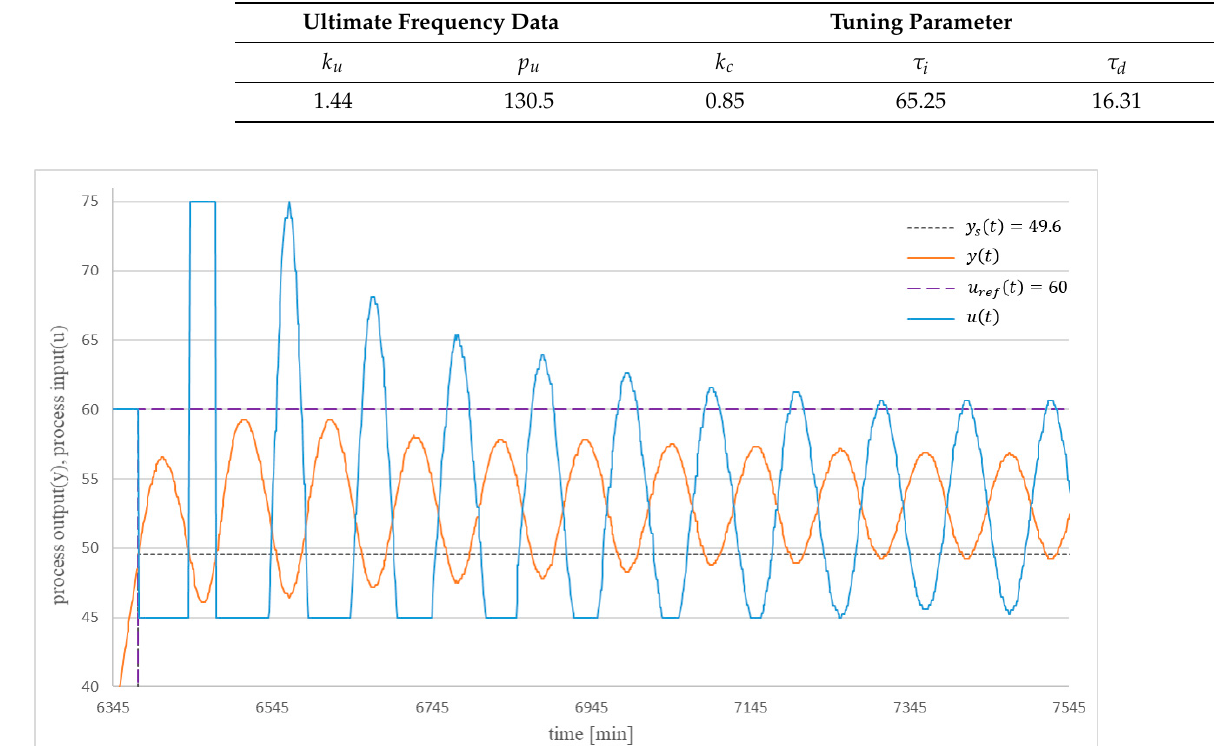
Table 10. Ultimate frequency response data and tuning parameters of the PID controller tuned by the relay feedback method [1].